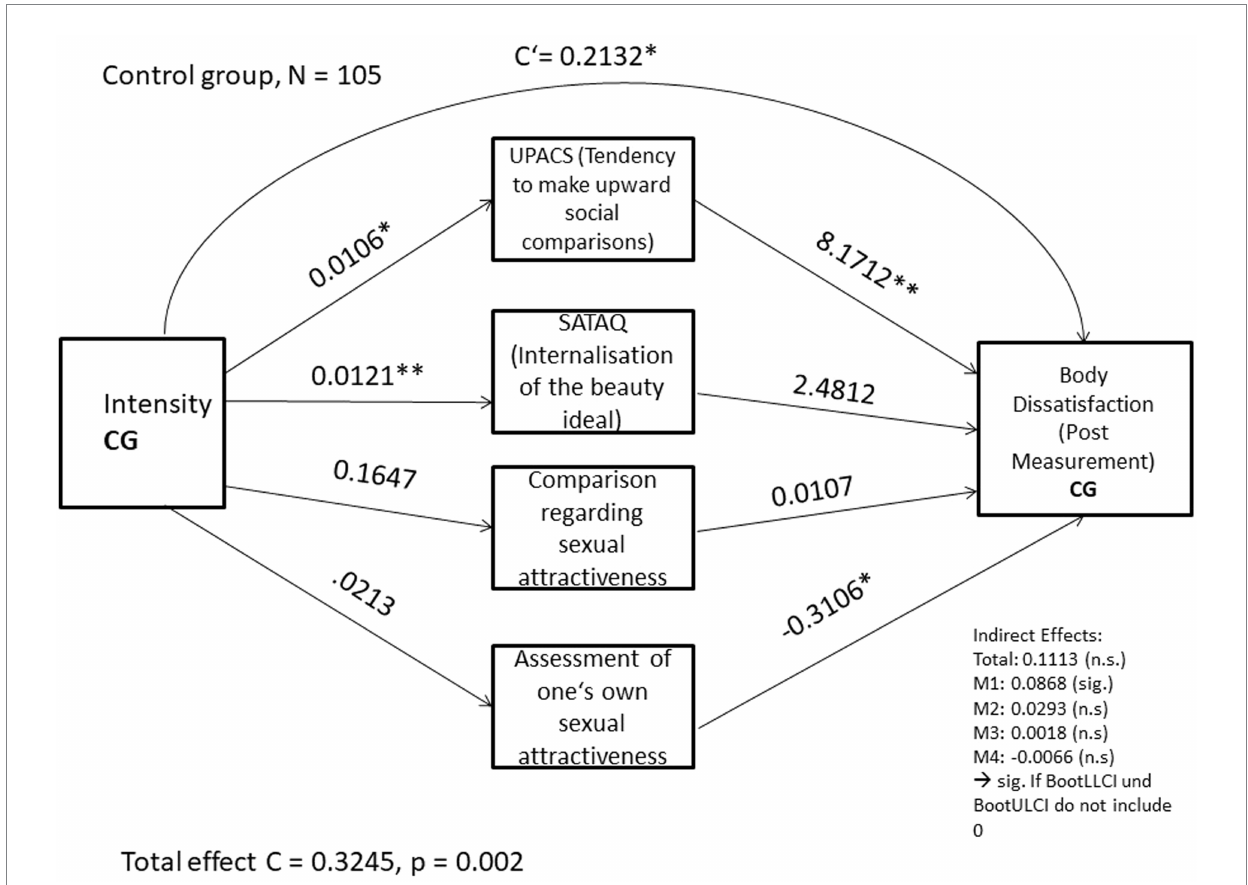
FIGURE 3 Calculated mediation model for the control group. The asterisks behind the coefficients indicate the significance level: * p < 0.05, ** p <